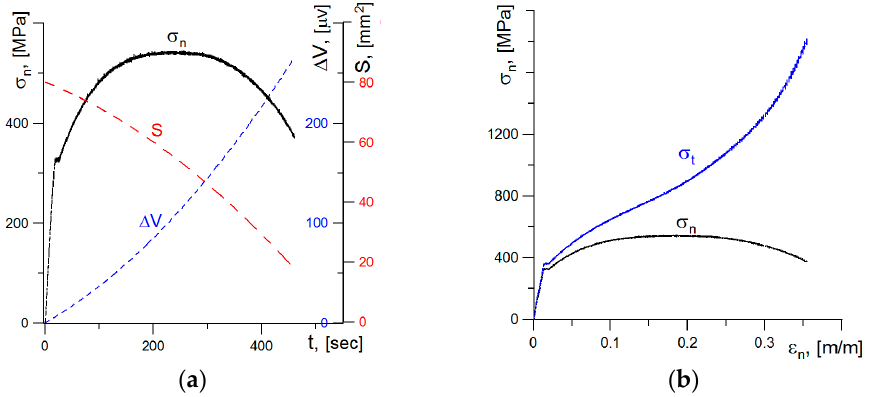
Figure 9. ( a ) The graphs of nominal stresses, potential increase, and minimum specimen cross- section during the tensile test; ( b ) the graphs of nominal and true stresses as a function of nominal